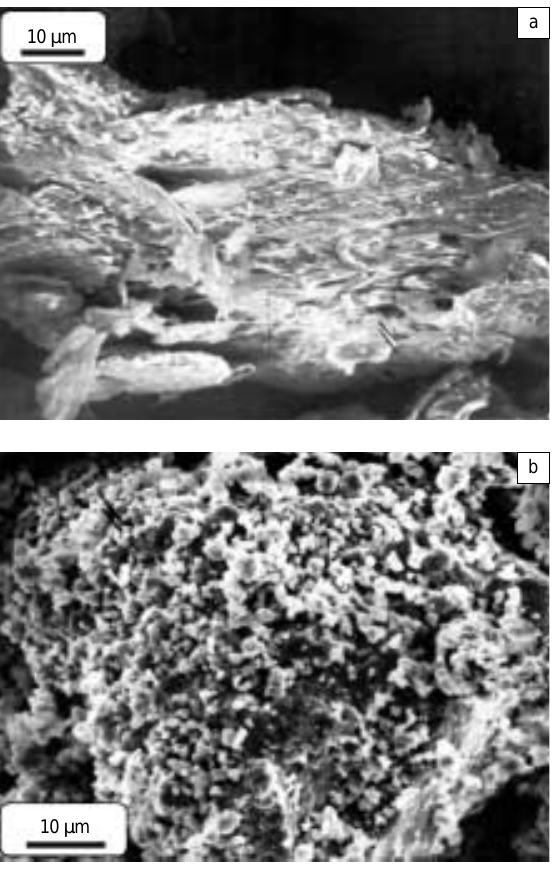
Fig. 3 Microphotograph of the SHS product in the system Ni 32 wt.% Al (a), the same product after mechanical activation for